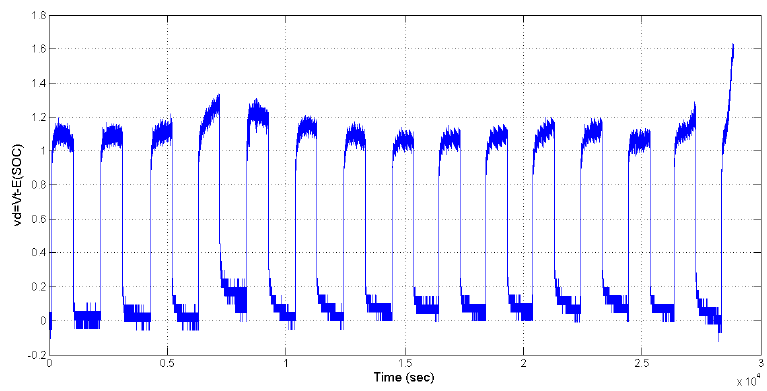
Figure 7. The subtraction between the open circuit voltage (OCV) and the terminal voltage ( v d ).